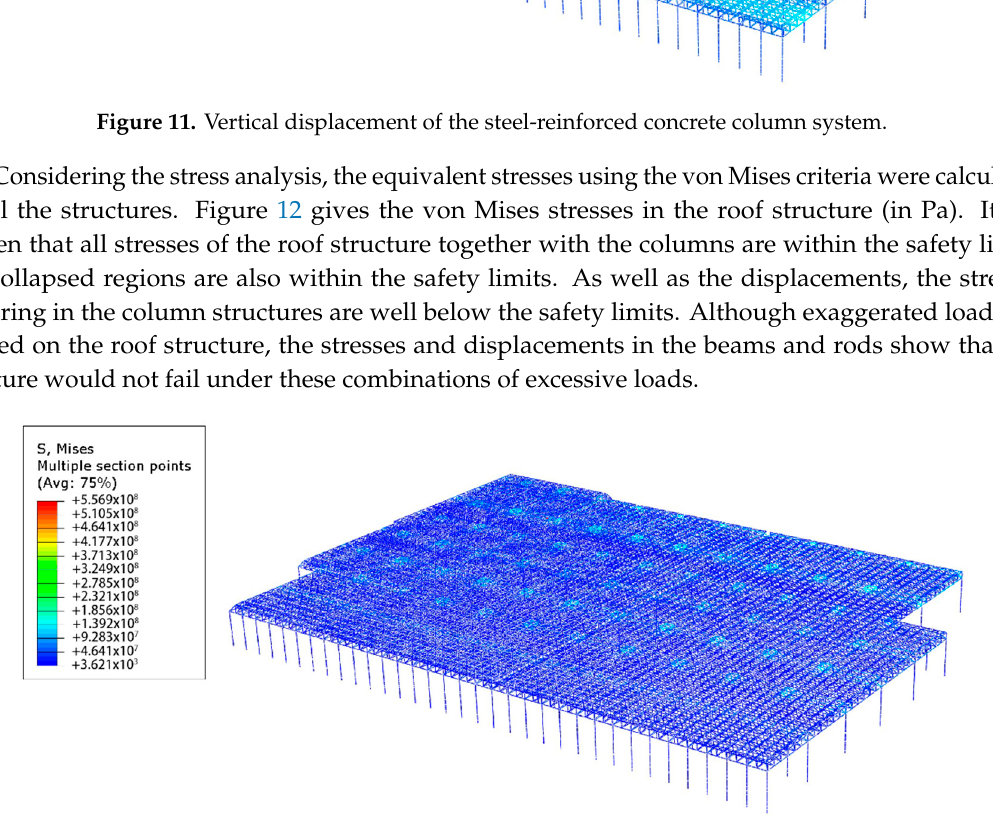
Figure 13. Connections with the supports and steel truss at the block interfaces.